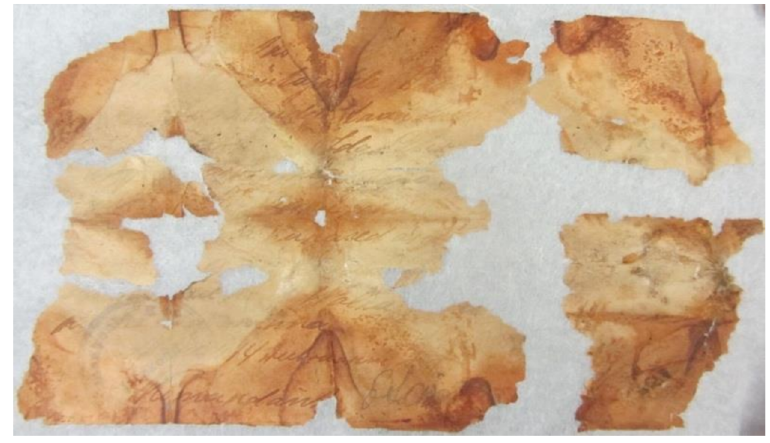
Figure 3. “Tunnistus” (Certificate).